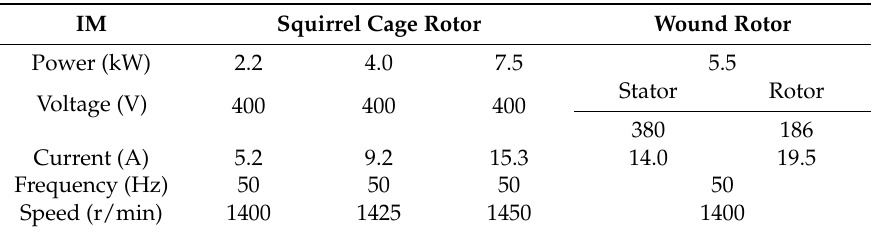
Table 1. Rated parameters of tested induction motors.